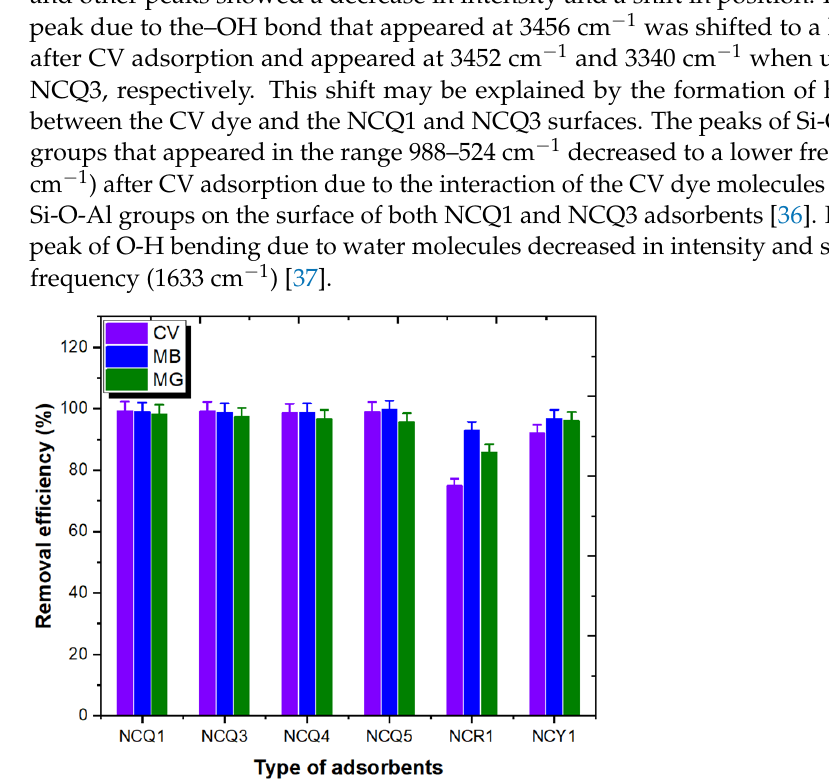
Table 1. Adsorption selectivity experiments with dye solutions.